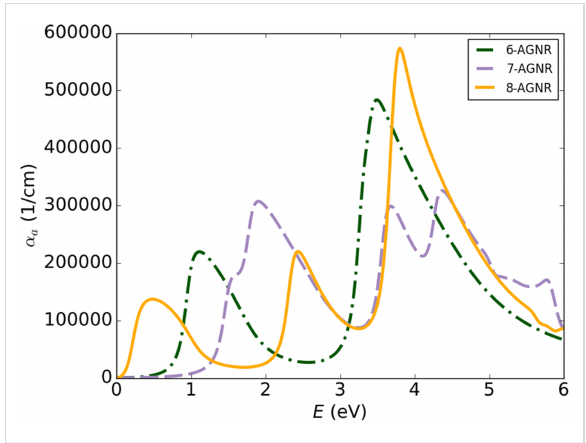
Figure 2: Absorption spectra for different AGNRs. 6-AGNR, 7-AGNR and 8-AGNR.